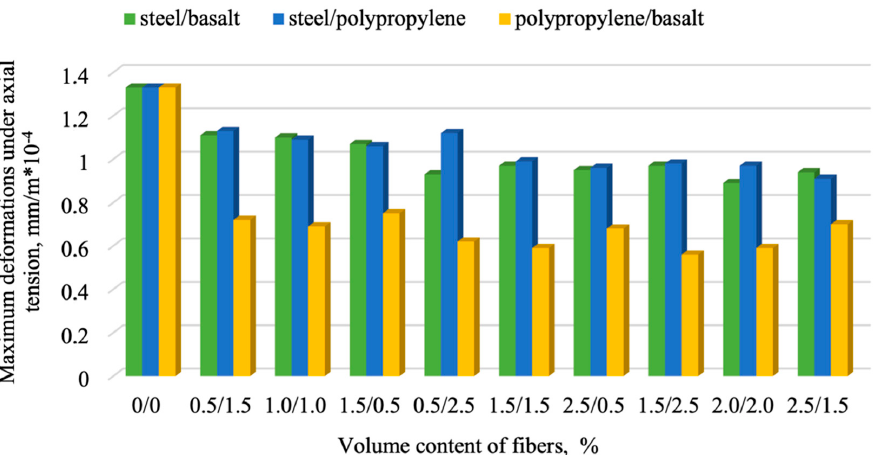
Figure 9. Dependence of the ultimate deformations of fiber-reinforced concrete under axial compression on the type of fiber combination and volume content.